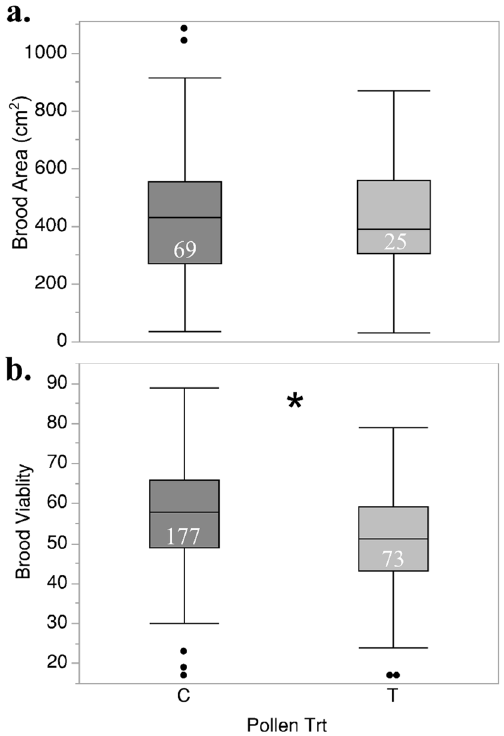
Figure 5. A comparison of cumulative brood area ( a ) and brood viability ( b ) between colonies headed by queens reared in colonies administered control (C) or treated (T) pollen supplements, * P < 0.05. The number of observations for each is shown inside each